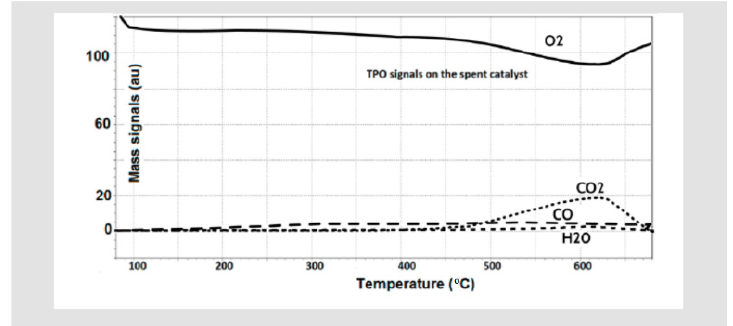
Figure 10. TPO spectrum on the spent catalyst.